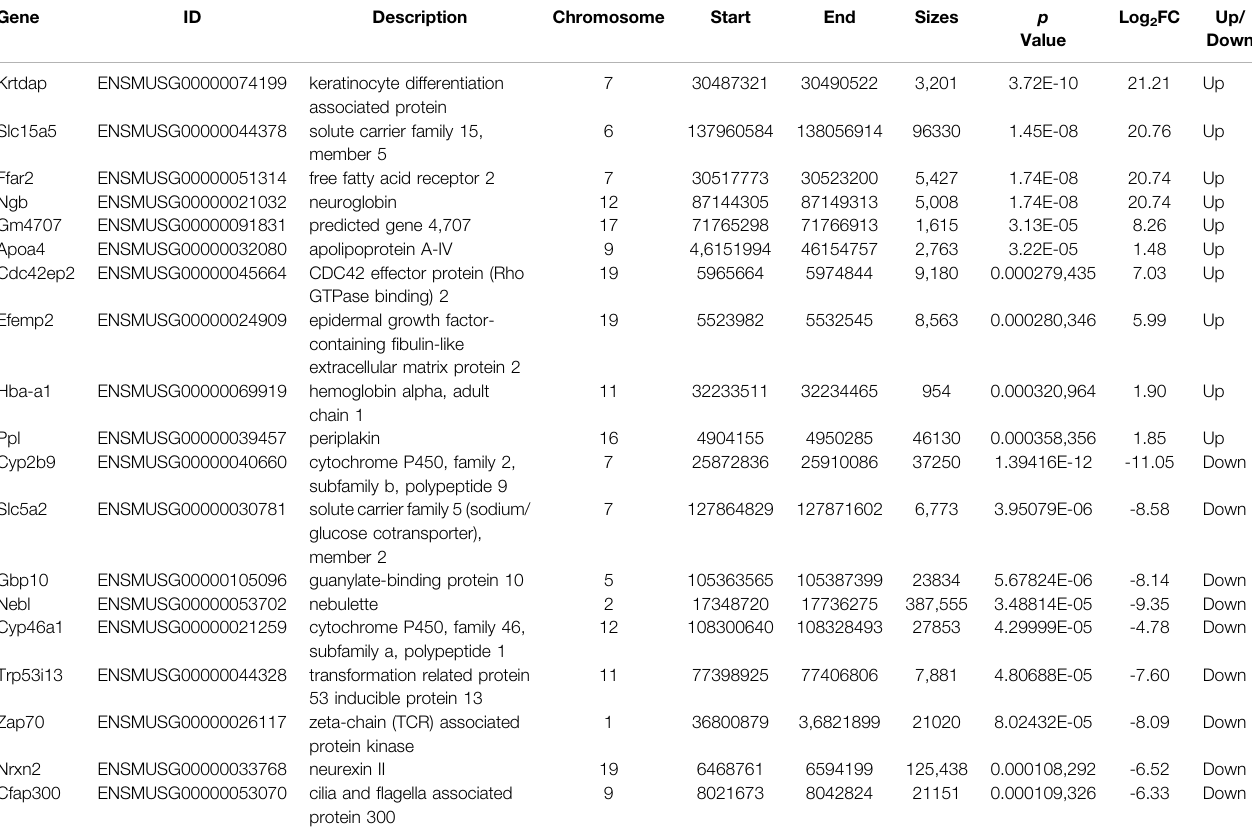
TABLE 2 | the top 10 up-regulated genes and top 10 down-regulated